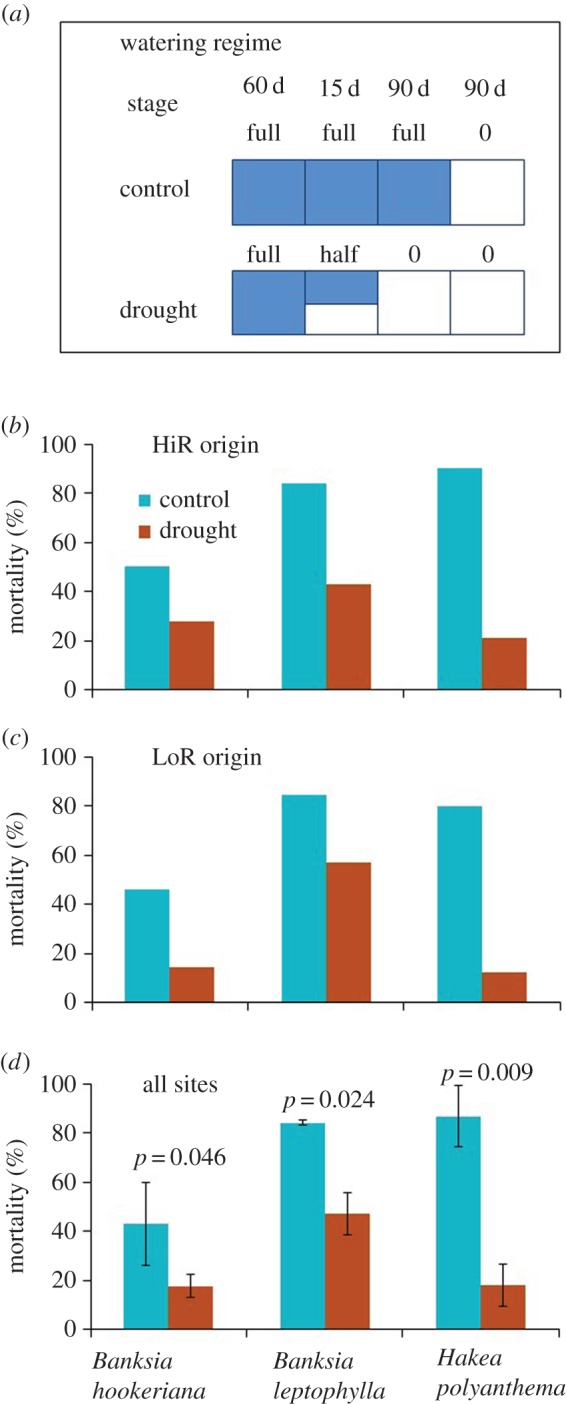
Watering regime and mortality (% at end of experiment) of seedlings derived from HiR and LoR sites of three species in the glasshouse experiment under three to six months of drought (Hakea costata was not included due to low survivorship, which left insufficient samples to be monitored further for mortality under drought). (a) Watering regime. Four stages were arranged, ranging from 15 days to 90 days over a period of 8.5 months; ‘full’ indicating full water supply (200 ml per plant, every second day) over the stage; ‘half’ indicating half water supply (100 ml per plant, every second day); ‘0’ indicating no water supply. (b) Mortality of seedlings from HiR sites; (c) mortality of seedlings from LoR sites; (d) mortality of seedlings over all sites in the two treatments. The p-values are probabilities of equal mortalities of seedlings from HiR and LoR sites (one-way ANOVA).